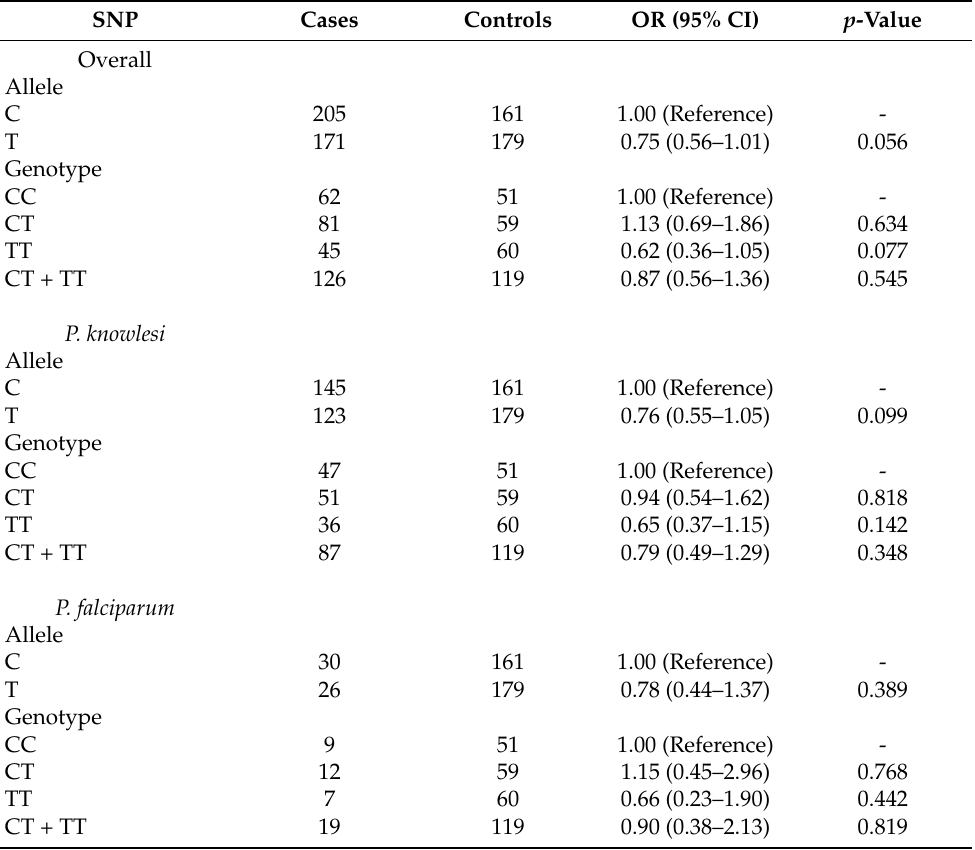
Table 5. Association of the β -like globin C-551T SNP with malaria